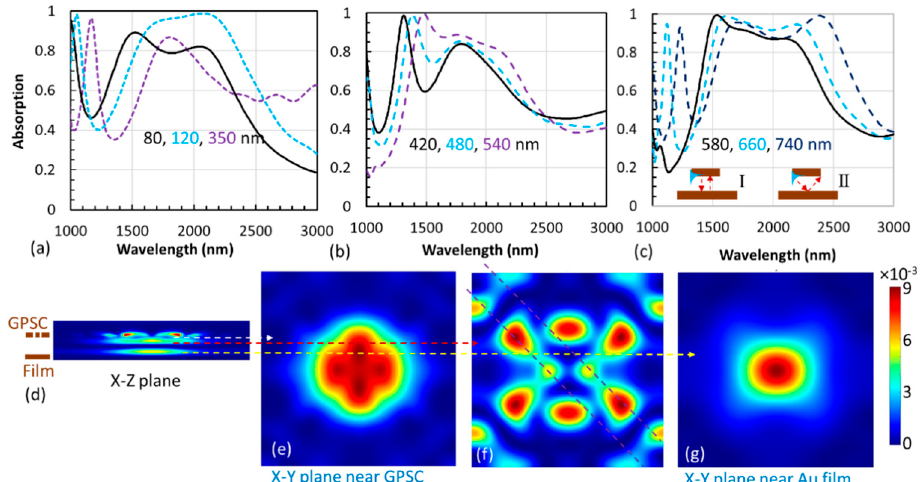
Figure 4. Simulated absorption in a stack of Au-GPSC/weakly-absorbing-spacer/Au-film with a spacer thickness of ( a ) (80, 120, 350 nm), ( b ) (420, 480, 540 nm) and ( c ) (580, 660, 740 nm). ( d ) E-field intensity in a cross section in the X-Z plane for a space thickness of 350 nm. ( e – g ) E-field intensity in a cross section in the X-Y plane through z-locations indicated by dashed white, red and yellow arrows, respectively. These E-field intensities are excited by a Gaussian source with a central wavelength of 1900